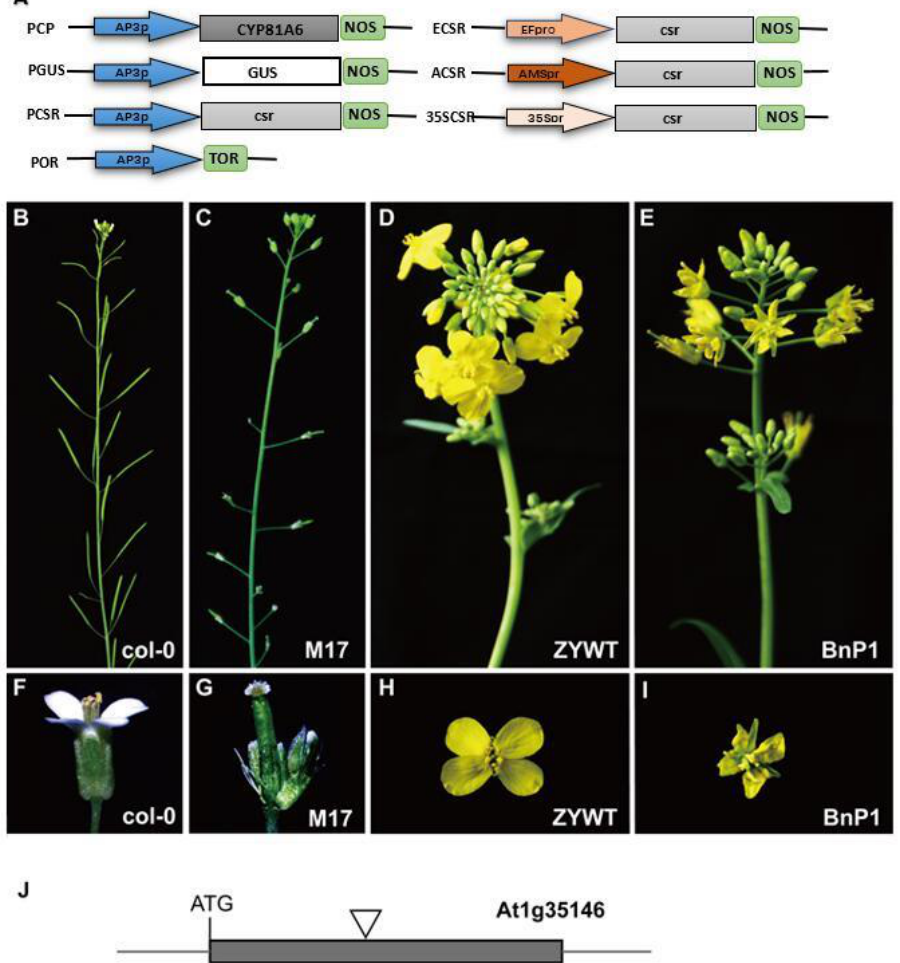
Figure 1. ( A ) Schematic illustration of constructs used to transform Arabidopsis and rapeseed. Arrows indicate the promoters. The fragments were cloned to the expression sites of pCAMBIA2300 ; ( B) feature of a wild silique of Arabidopsis ; ( C ) feature of a male sterile transgenic line without petals and stamens of Arabidopsis ; ( D ) rapeseed with normal inflorescence; ( E ) transgenic inflorescence of rapeseed (BnP1) with defective petals; ( F ) a wild flower with normal petals of Arabidopsis ; ( G ) a male sterile transgenic Arabidopsis flower without petals and anthers on top of a filament; ( H ) a wild flower of rapeseed; ( I ) a transgenic flower of rapeseed (BnP1) with wizened petals; ( J ) DNA insertion occurred in the exon of At1g35146 based on the results from TAIL-PCR analysis. Grey box: Exon; grey lines: Intergenic sequences; black triangles: Location of transgenes.